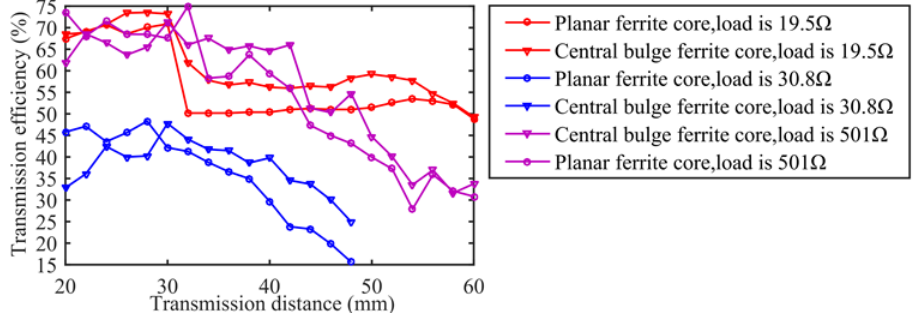
Figure 15. Curves of transmission efficiency at different load